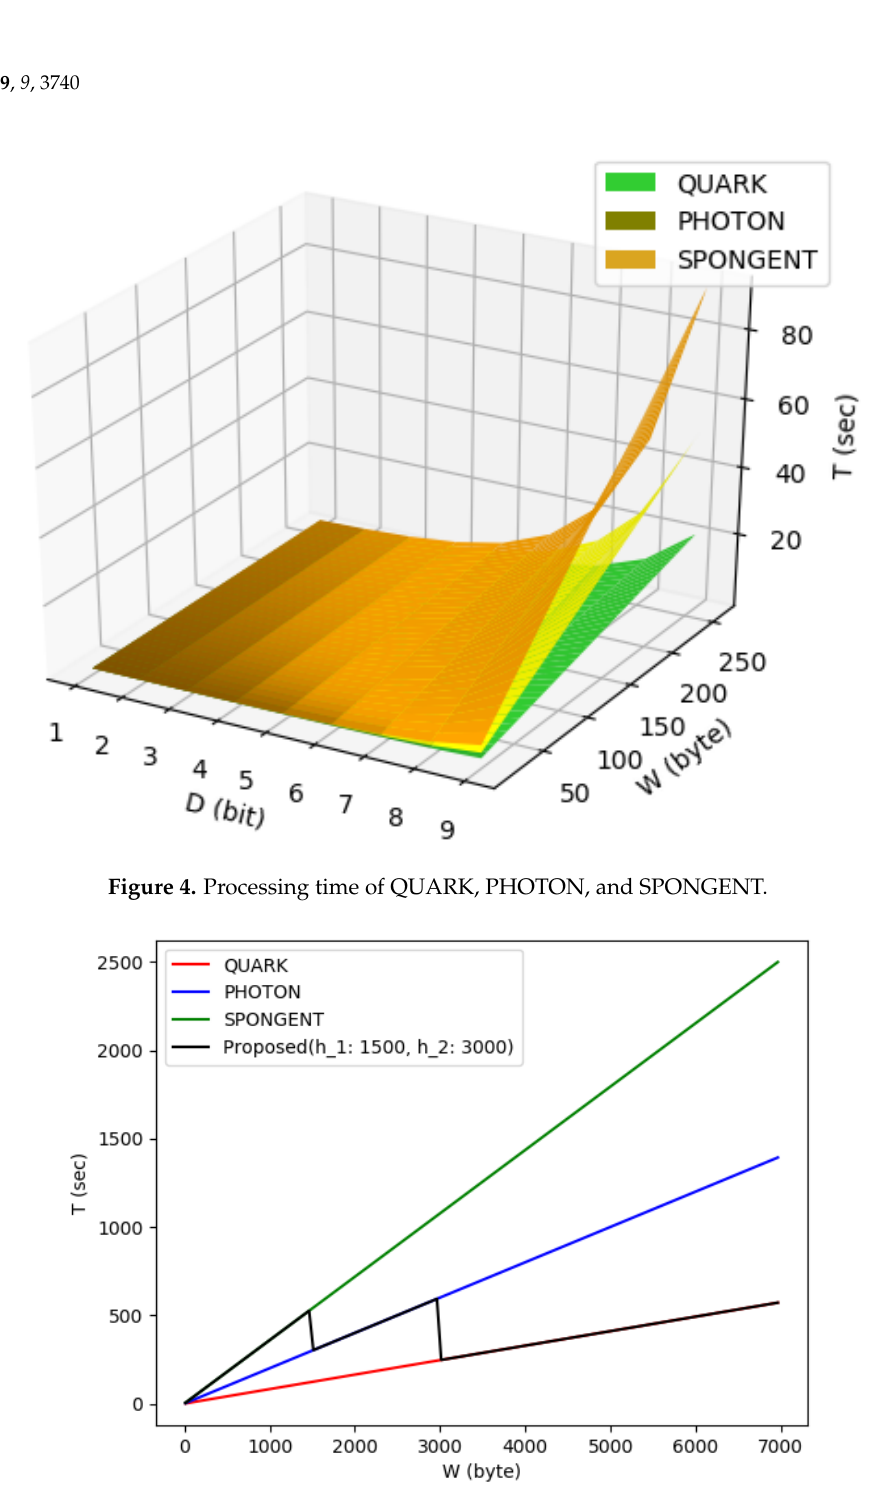
Figure 5. Result of changing hash